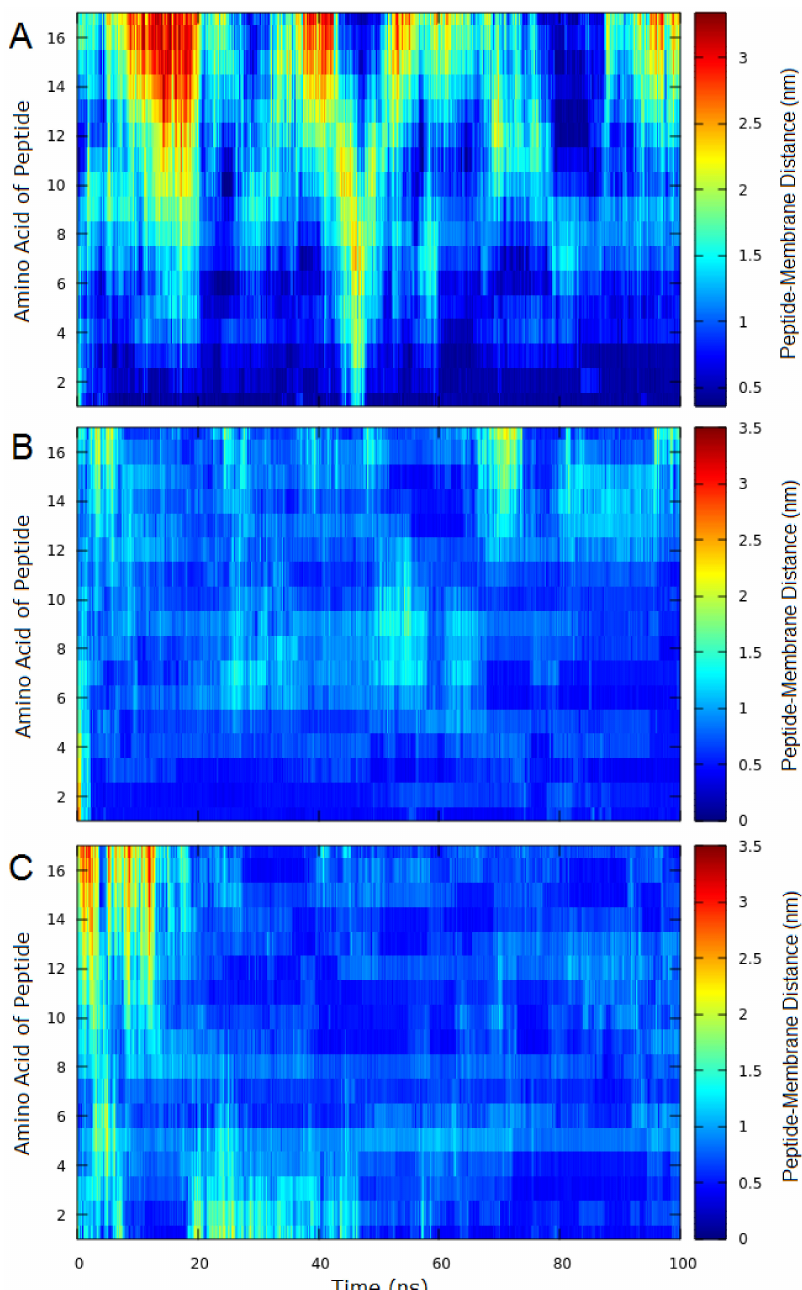
Figure 3. Peptide–membrane distance over time by amino acid during 100 ns MD simulations for ( A ) Stigmurin, ( B ) StigA25 and ( C ) StigA31. The distance between the atoms (except hydrogen) of each amino acid of the peptides and phosphorus atom (hydrophilic head of the lipids) was